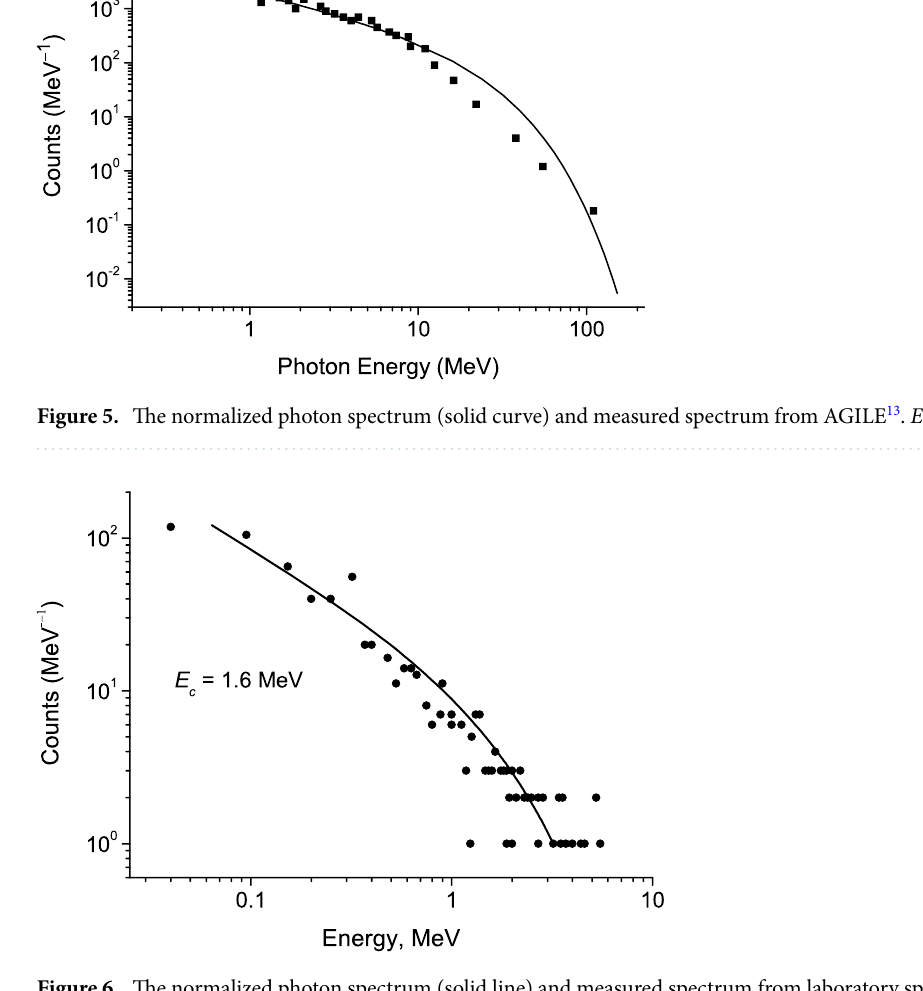
Figure 6. The normalized photon spectrum (solid line) and measured spectrum from laboratory spark discharge 7 . E c = 1.6